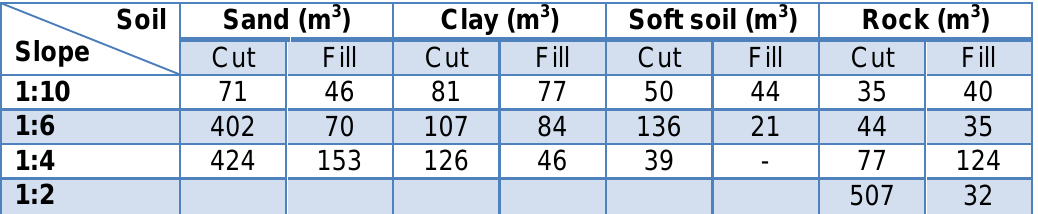
Table 3: Summary of average cut & fill by soil and slopes types Soil Sand (m 3 Slope